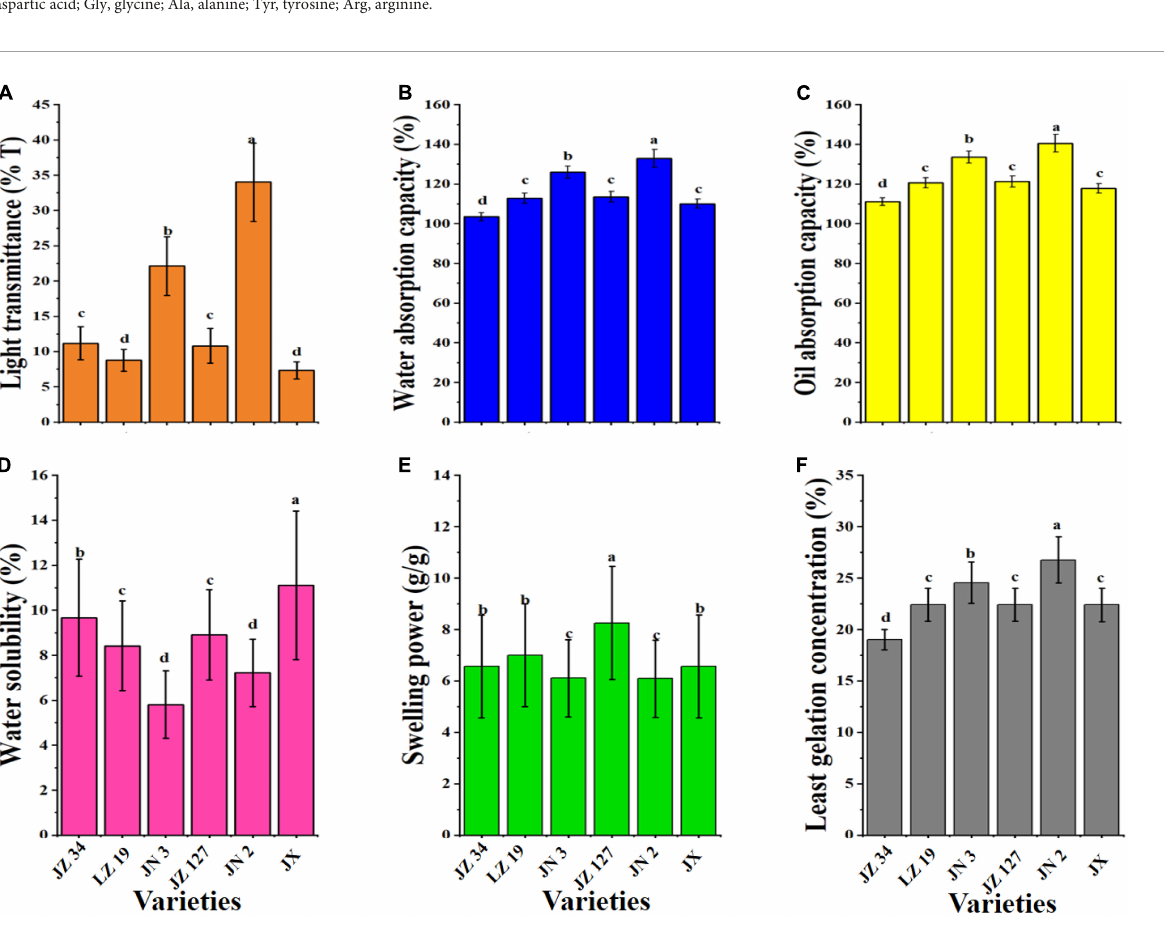
FIGURE5 Functional properties of sorghum grains. Light transmittance (A) , water absorption capacity (B) , oil absorption capacity (C) , water solubility (D) , swelling power (E) , and least gelation concentration (F) . JZ 34, jinza 34; LZ 19, liaoza 19; JN 3, jinnuo 3; JZ 127, jiza 127; JN 2, jiniang 2; JX, jiaxian. The data showed the mean of three replications, and error bars are standard deviations. Different letters (a–d) indicate there were significant differences ( p < 0.05) in the LSD mean comparisons between the treatments